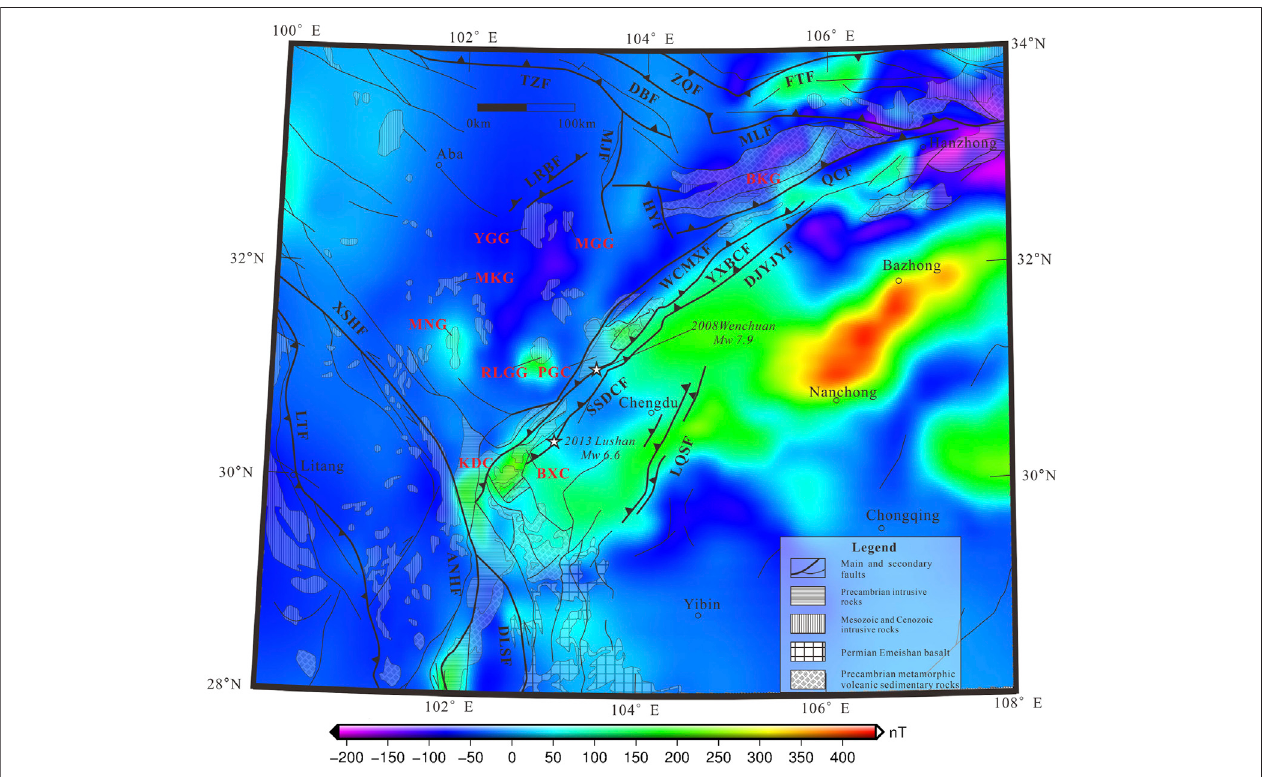
FIGURE 4 | The RTP magnetic anomaly calculated from Figure 3 .